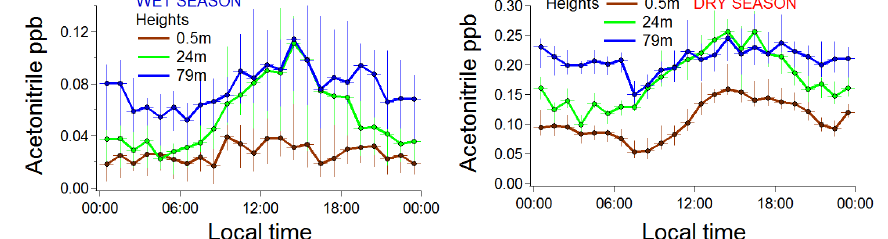
Figure 10. Diurnal hourly median acetonitrile mixing ratios during the wet season (left) and the dry season (right) for different heights. Range bars represent the 75 and the 25%